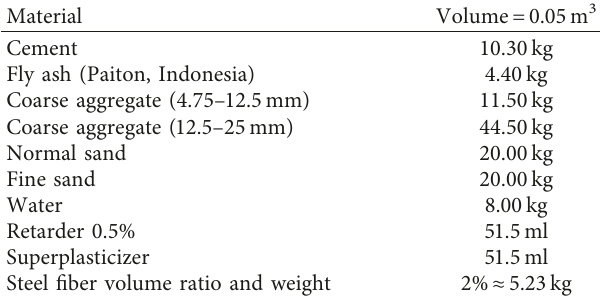
Figure 1: Physical and mechanical properties of steel fiber used in the study: tensile strength R m,nom 1225N/mm 2 ; (cid:31) Table 1: Concrete mixture proportion from mix design.